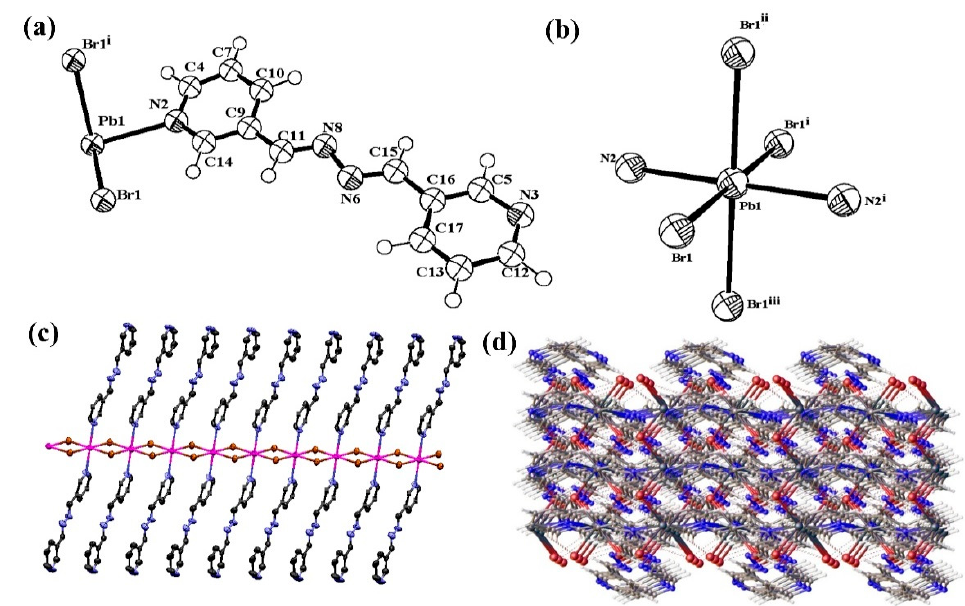
Figure 2. ( a ) Molecular structure of asymmetrical unit ( 1 ). ( b ) Coordination sphere of Pb(II) in 1. ( c ) Fragment of the coordination polymer showing the 1D fish bone metal–organic coordination polymer. ( d ) From 1D architecture to supramolecular 3D coordination polymer via labile interactions (such as aromatic and π – π interaction, H-bonding).